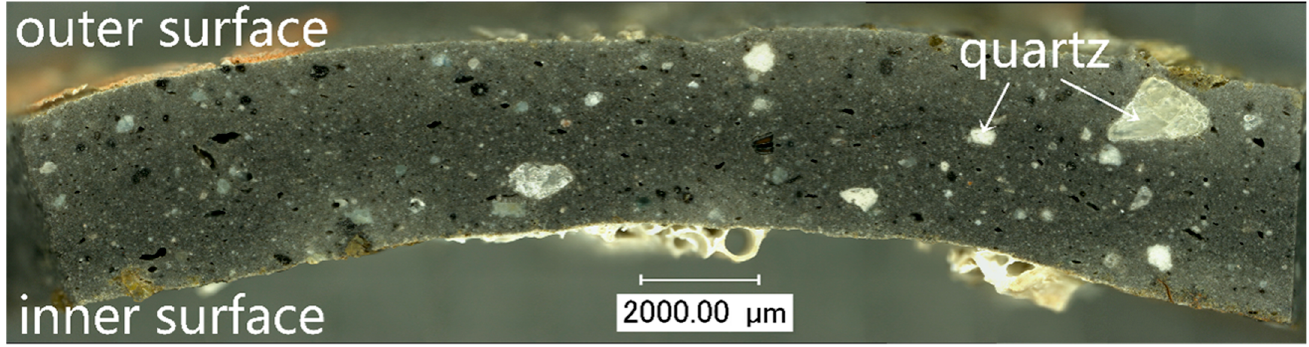
Figure 3. OM image of the cross-section of sample DL-2, showing a lot of quartz particles in the